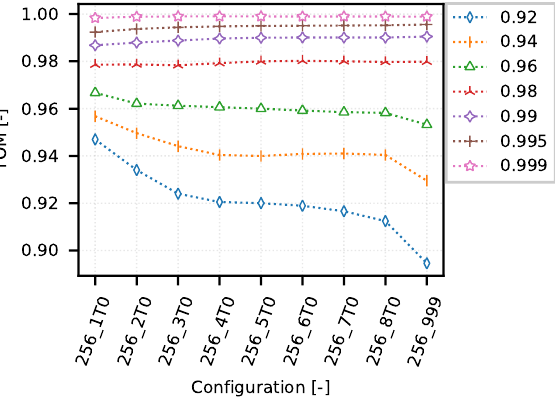
Figure 8. CSMA/CA—example of optimization curves (mean quantiles 0.92–0.999 of 256_5T0